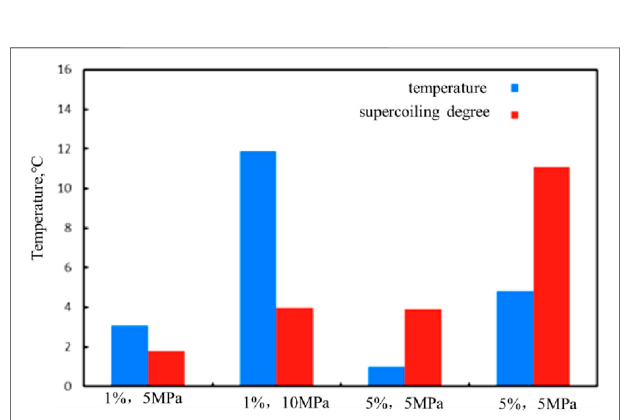
FIGURE 10 | Analysis of supercooling degree under different concentration and pressure